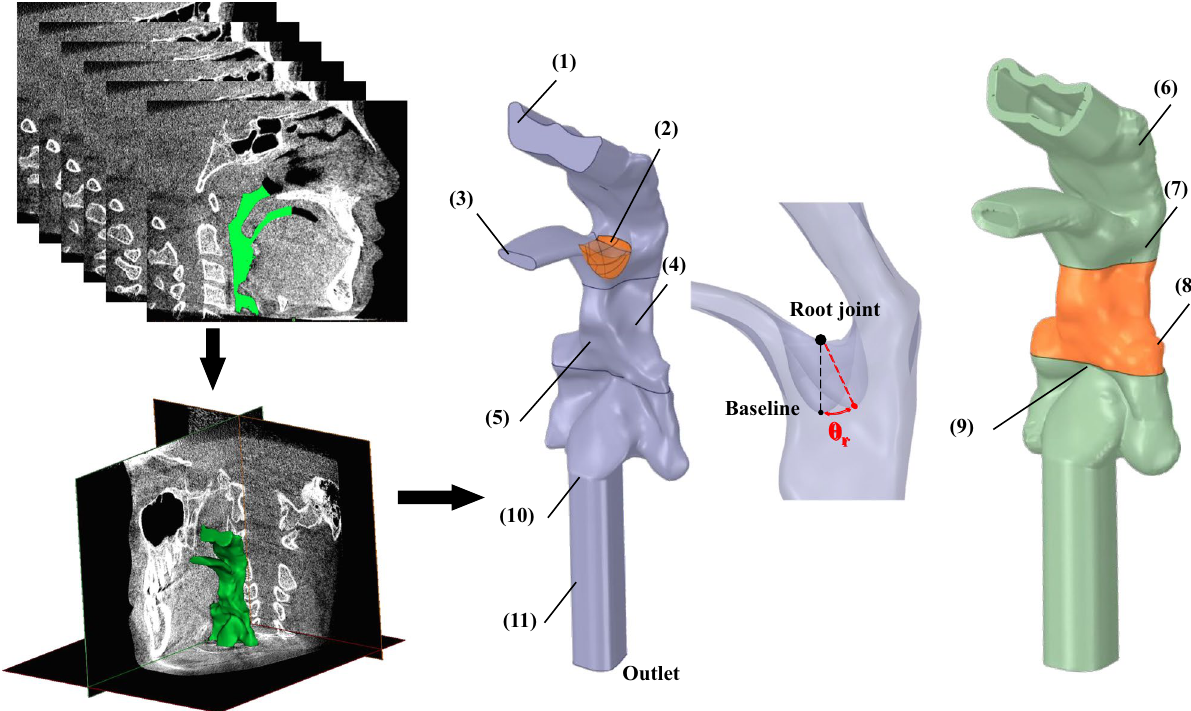
Figure 7. Reconstruction procedure of the fluid region and pharyngeal structure with identified boundary regions. (1) Inlet of nasopharynx, (2) uvula, (3) inlet of oral cavity, (4) tonsil surface, (5) surface of the tongue base, (6) structure of nasopharynx, (7) structure of velopharynx, (8) structure of oropharynx (deformable), (9) epiglottis, (10) bottom of pharyngeal airway, (11)